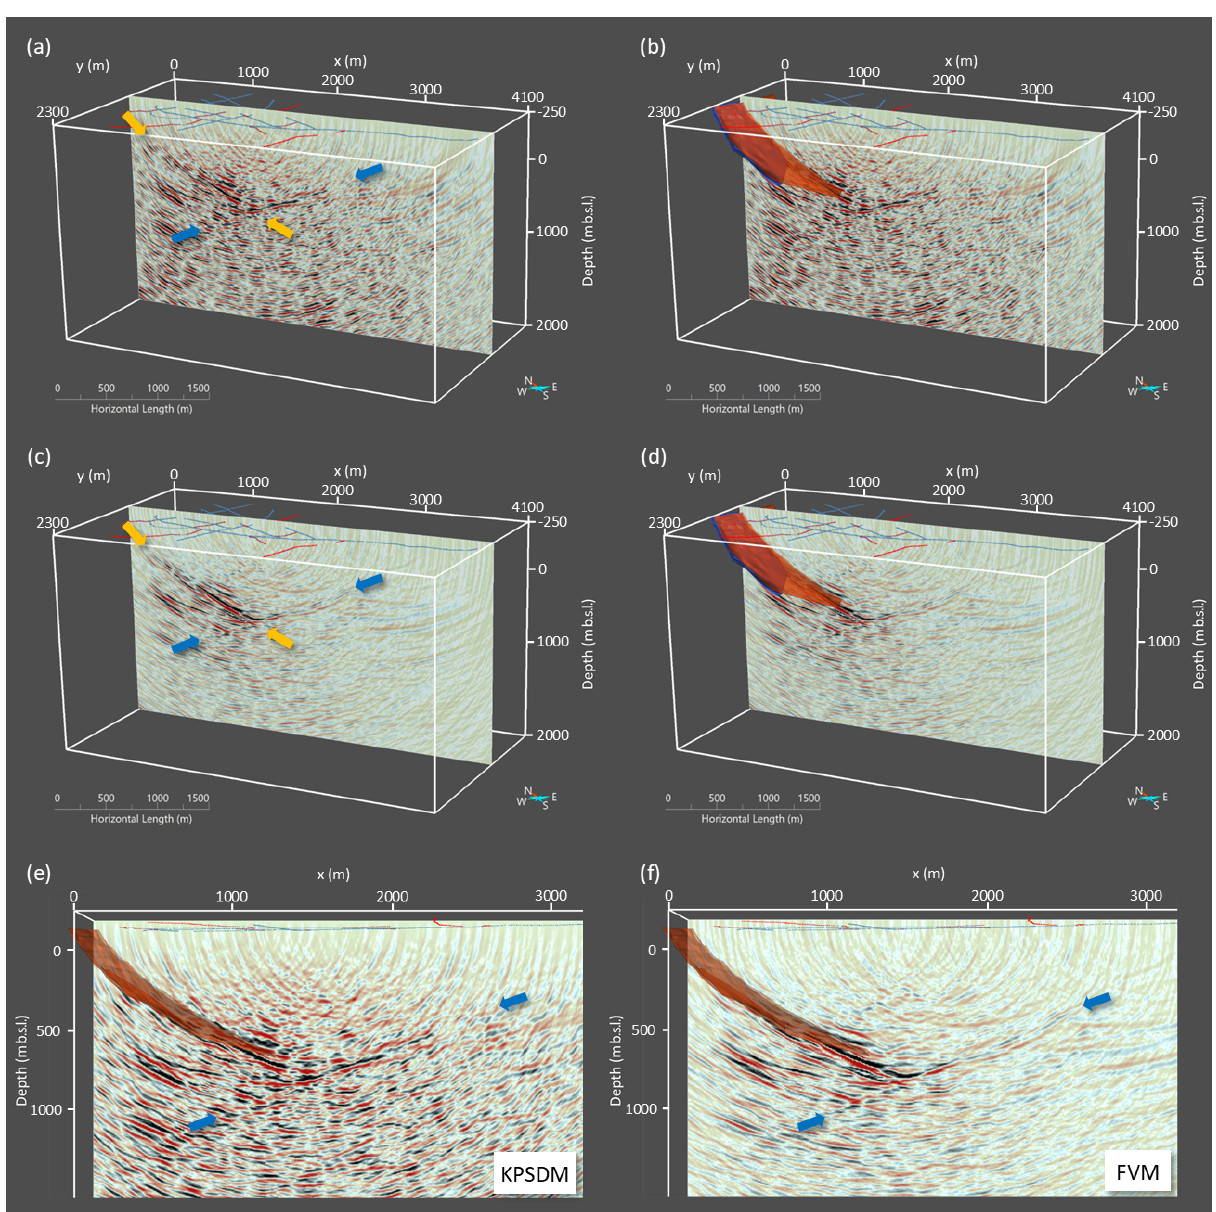
Figure 6. Depth slices through the KPSDM result( a , b , and e ) and the FVM result ( c , d , and f ) using a constant velocity of 5600ms − 1 for migration, shown in (a) and (c) without and in (b) and (d) with the known mineralization layers in red and blue. The yellow and blue arrows in (a) and (c) mark the image of the main mineralization reflector and a crosscutting reflector dipping in the opposite direction. Panels (e) and (f) are a 2D view of the results for KPSDM and FVM, respectively. The gain for plotting was chosen such that the reflectors of the main mineralization appear in the same intensity for both techniques (KPSDM and